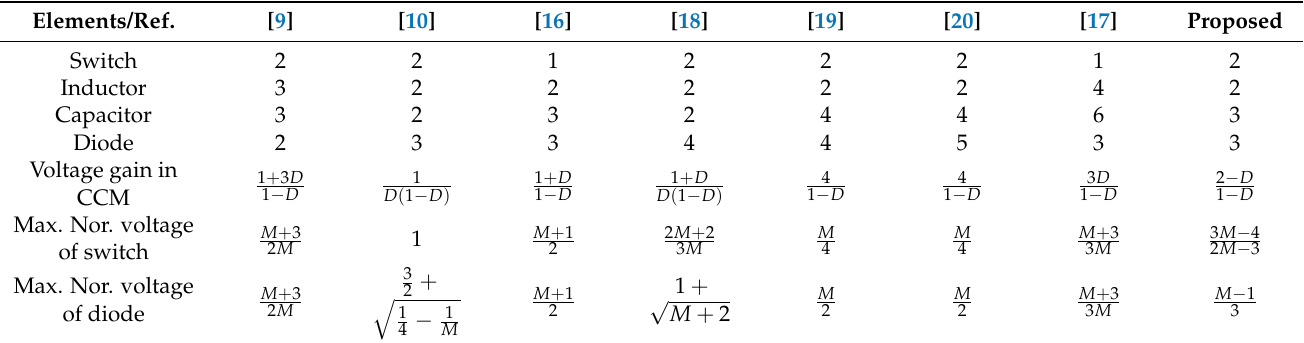
Table 2. Comparison between proposed converter and the existing topologies.